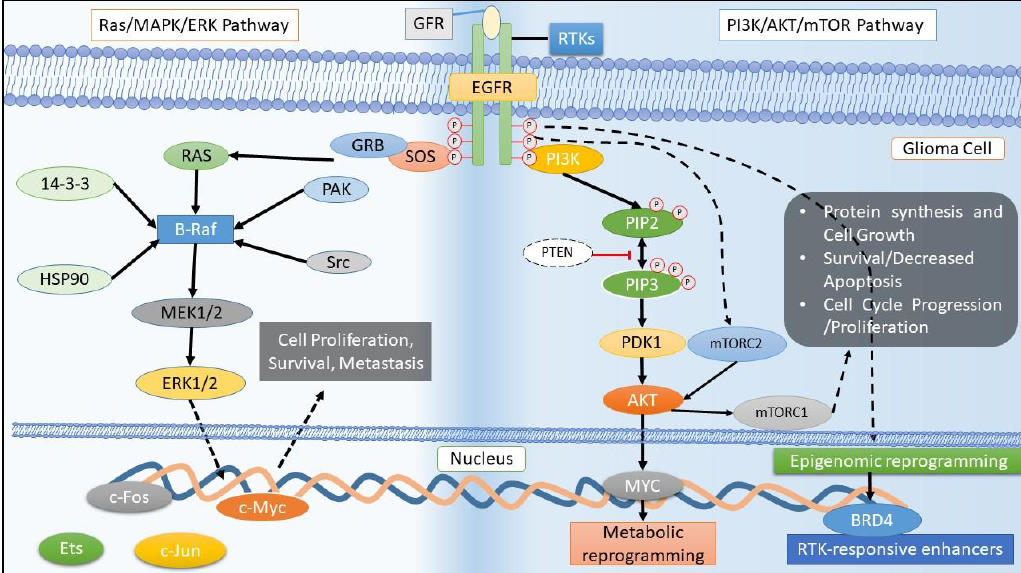
Figure 1. Schematic representation of Receptor Tyrosine Kinases (RTK) activation and the downstream signaling. RTKs, particularly epidermal growth factor receptors (EGFR), are amplified in glioblastoma, which significantly alters the nutrient uptake and utilization. The Rapidly Accelerating Sarcoma/mitogen activated protein kinase/extracellular-signal-regulated kinase (Ras/MAPK/ERK) and phosphatidylinositol 3-kinase/a serine/threonine protein kinase/mammalian target of rapamycin (PI3K/AKT/mTOR) pathways get activated through the stimulation by growth factor receptor (GFR). Physiologically, these two pathways orchestrate to execute cell proliferation, survival, motility, adhesion, and angiogenesis. Any deregulation in these pathways leads to an activation of oncogenic signaling cascades causing glioma.